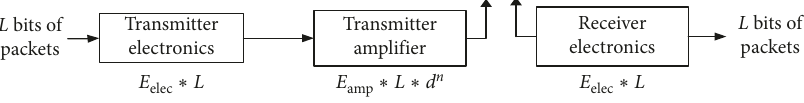
Figure 1: Radio model for energy